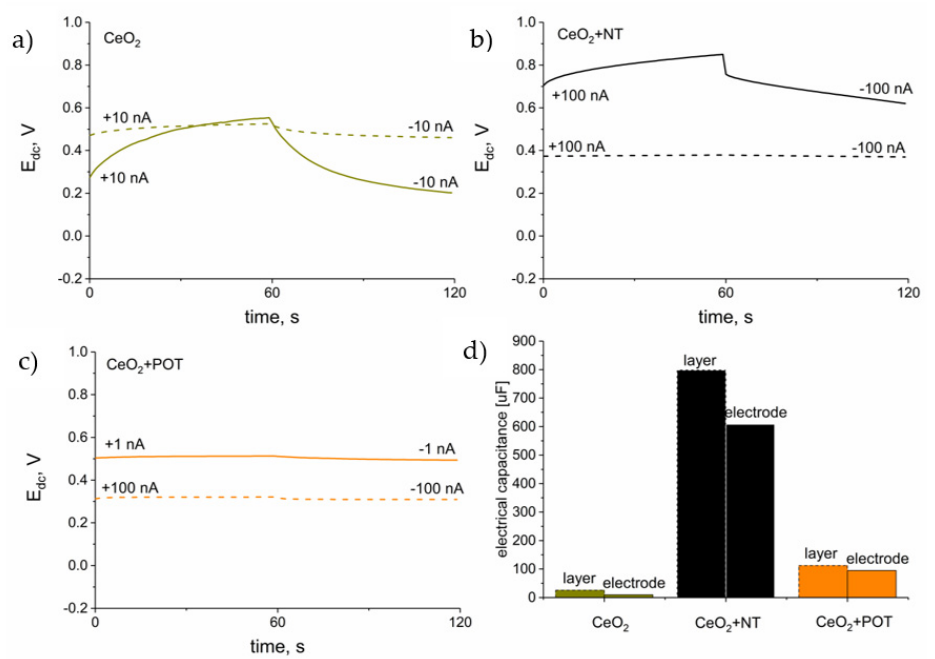
Figure 3. Chronopotentiograms of the studied materials and: ( a ) hydrous cerium dioxide (dark yellow line), ( b ) hydrous cerium dioxide—carbon nanotubes (black line), ( c ) hydrous cerium dioxide—poly(3-octylthiophene-2,5-diyl) (orange line). Solid-lined graphs refer to the solid-contact electrode and dash-lined ones—to solid-contact layers. Values of electrical capacitance parameter of electrodes and layers were compared on the diagram ( d ).